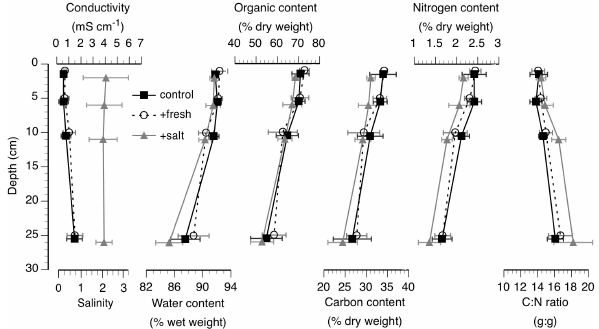
Fig. 4. Soil properties. Values for the control treatment are plotted at the midpoint of each depth interval, with depths for the + fresh and + salt treatments jiggered by ± 0.5cm to reduce overlap of symbols and error bars. Values are means ± standard deviation, n = 5 plots per data